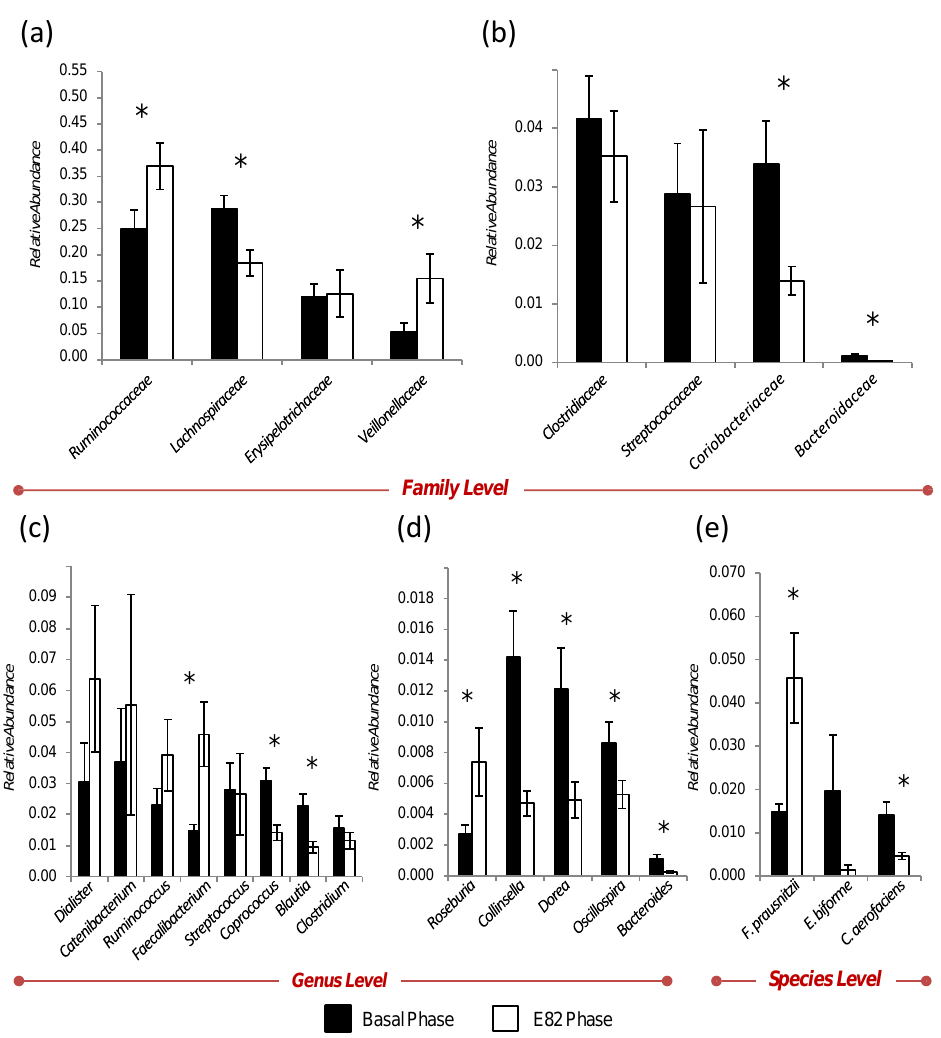
Figure 4. Differences in the gut microbiota composition between basal phase and E82 phase at family, genus and species level. In the bar diagrams are represented: (a) bacterial families whose average relative abundance is greater than 10%; (b) bacterial families whose average relative abundance is less than 10% but greater than 1%,with the exception of the family Bacteroidaceae (0.07%of averagerelative abundance); (c) bacterial genera whose average relative abundance is greater than 1%; D) bacterial genera whose average relative abundance is less than 1%; E) bacterial species whose average relative abundance is ≥ 1%. Values are the mean ± S.E.M. The statistically signi ficant differences between each phase were tested by non-parametric Kruskal-Wallis test. * P <0.05.